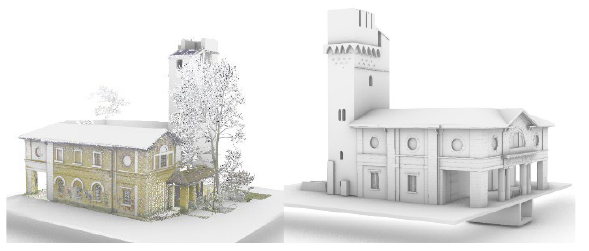
Figure 7 . From the point cloud to the Nurbs